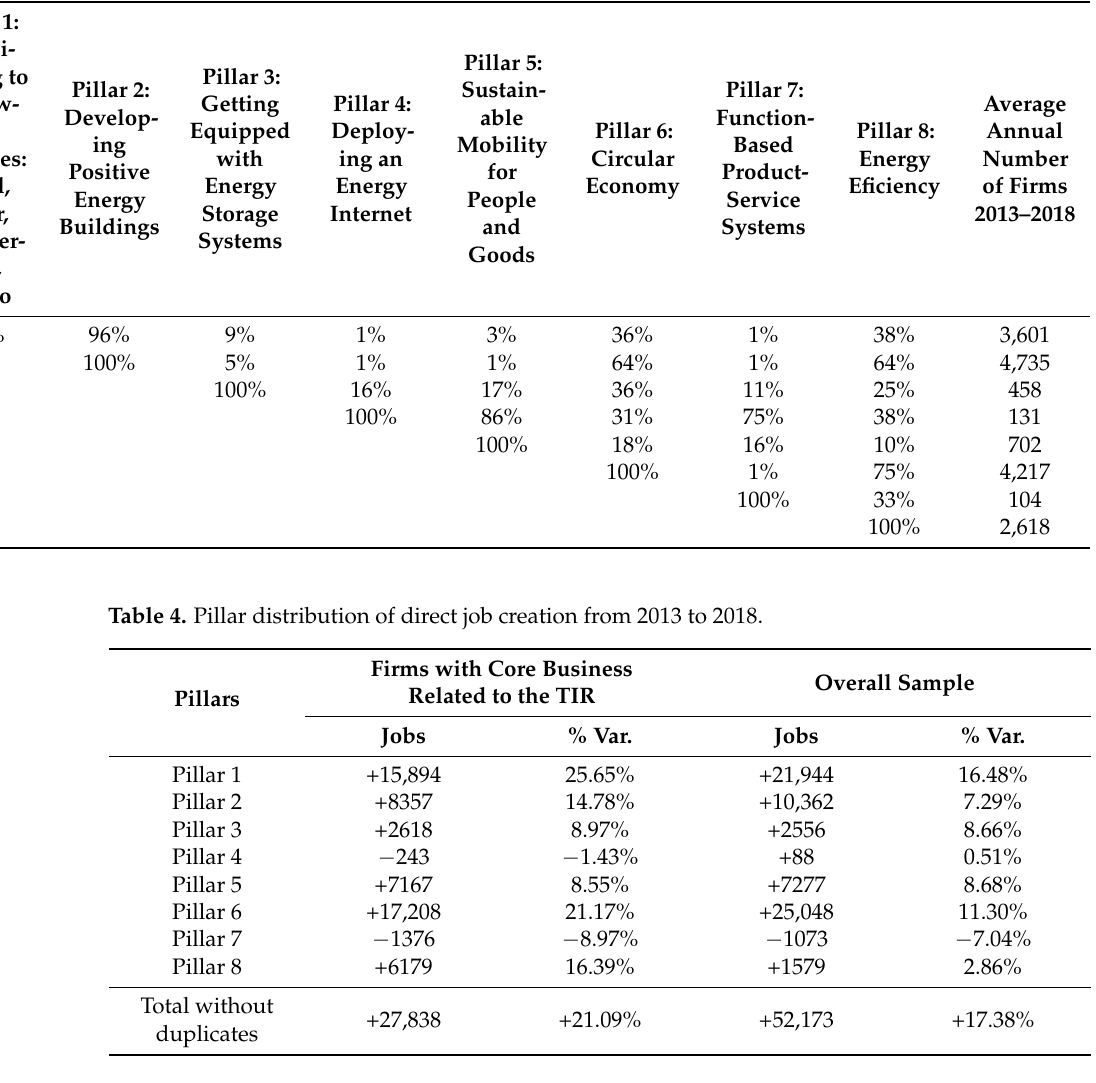
Table 3. Table of contingency of number of firms by pillar.